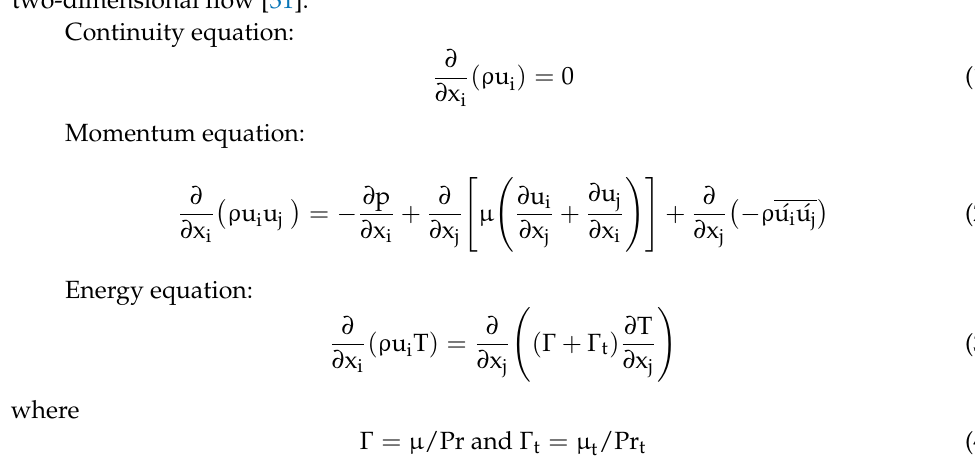
Table 2. Values of operating parameters for numerical analysis.